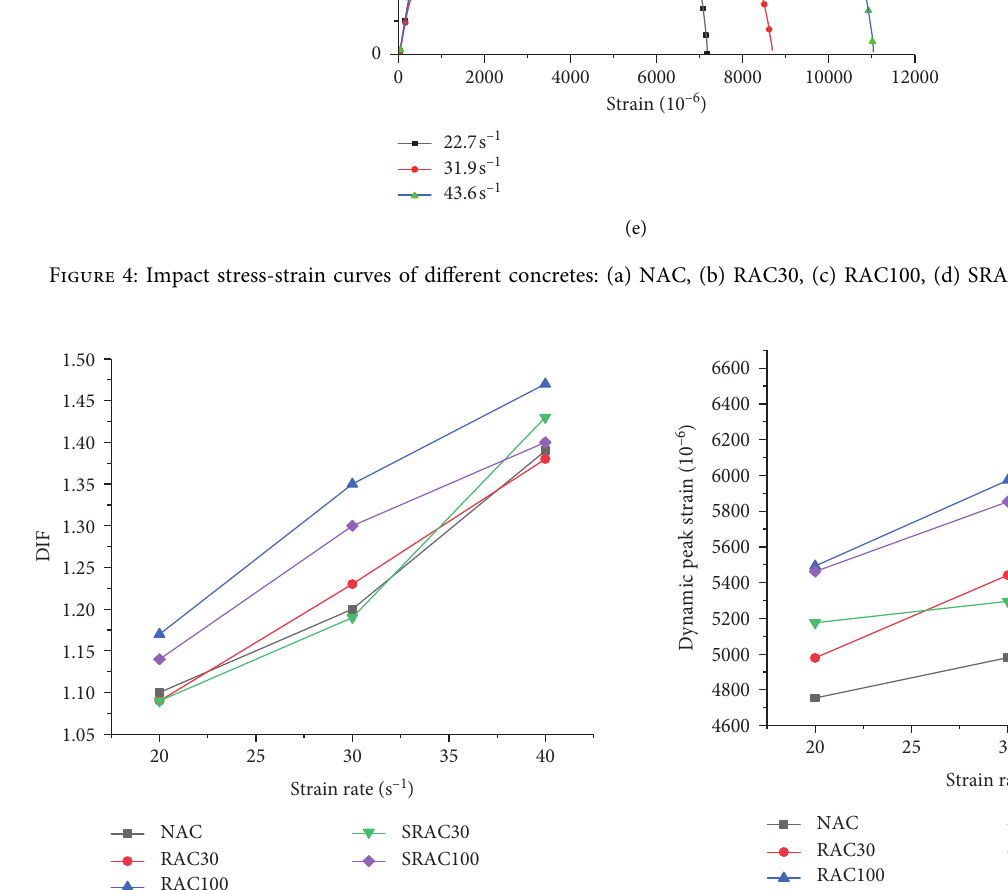
Figure 5: DIF values of concrete specimens under different strain rates.